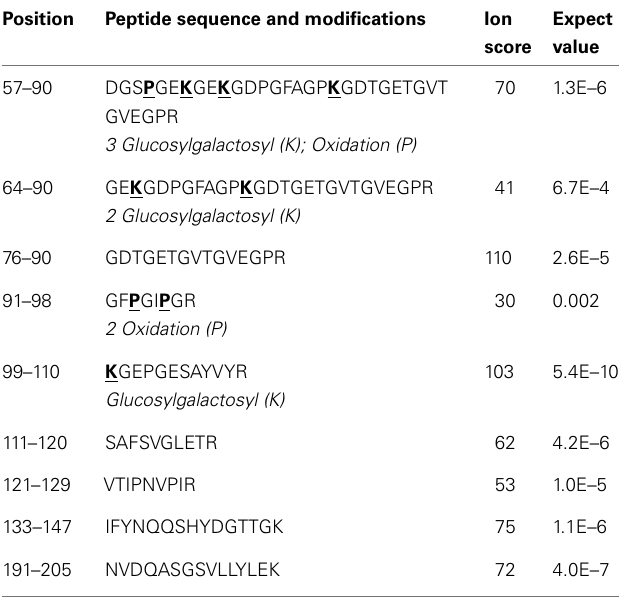
FIGURE 1 | Observed dolphin adiponectin post-translational modifications . Adiponectin residues were aligned using UniProt alignment (ClustalO) with UniProt/SwissProt sequences and the Ensembl Tursiops truncatus sequence. Signal peptides were removed and sequences manually aligned around HumanThr20–Thr22 similar to Richards et al. (35).The collagen domain was assigned based on G-X-Y-G repeats as inWang et al. (33).